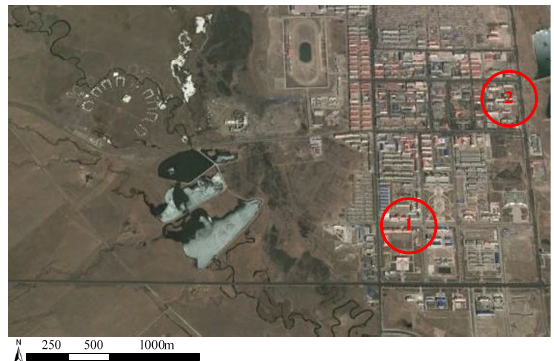
Figure 7. Study Area: the Jinyintan grassland, Qinghai, China. The imagery is from Google Earth.